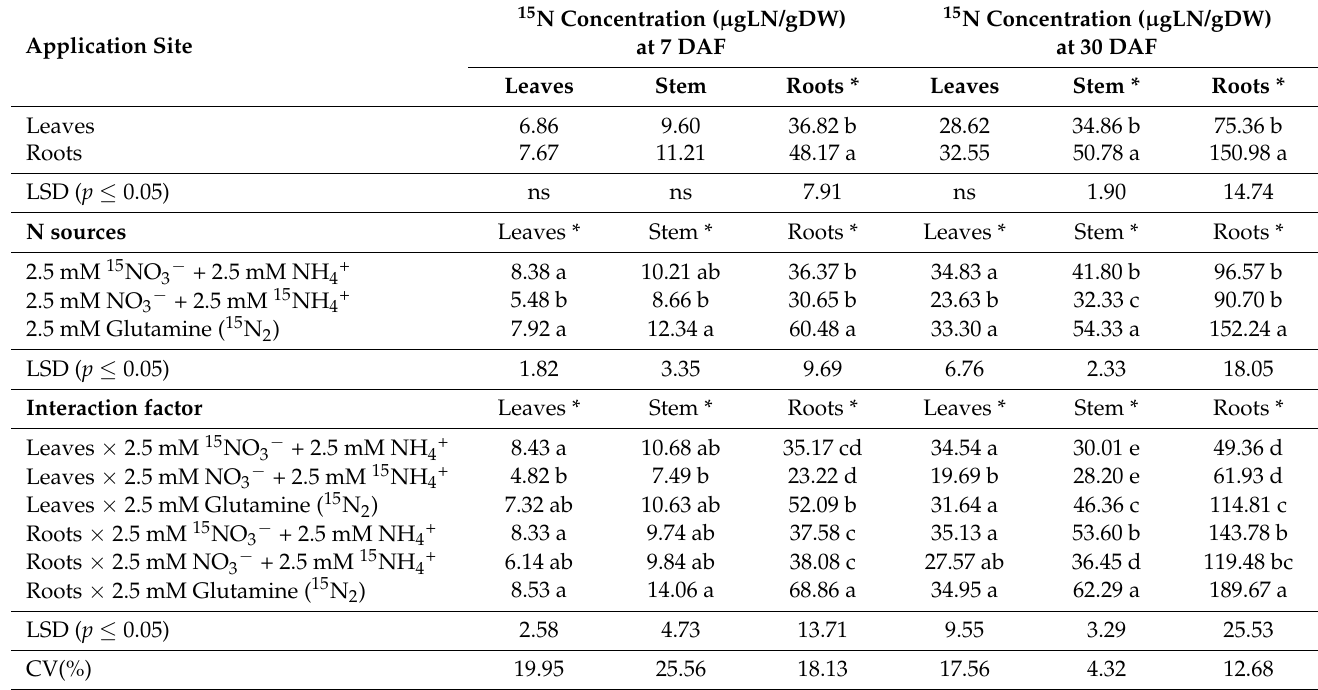
Table 1. N sources and application parts effected by the labeled N concentration in Vanda ‘Patchara Delight’